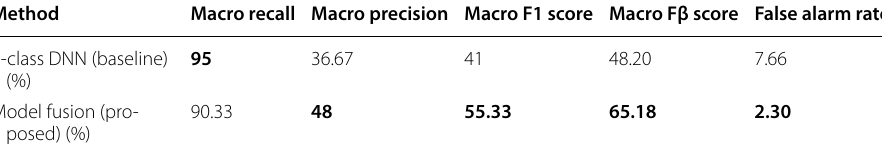
Table 7 Classification results for the proposed and the baseline models calculated with macro averaging